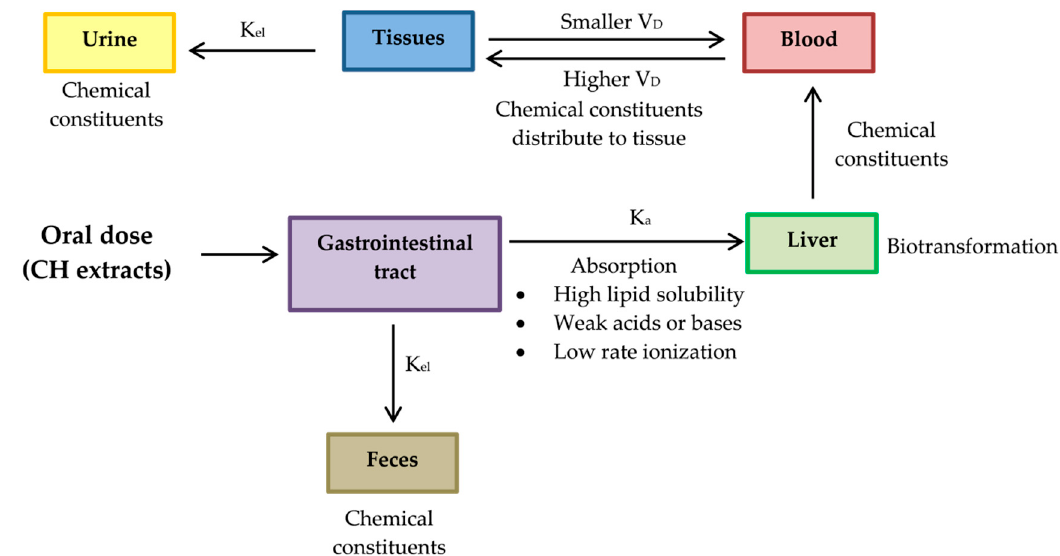
Figure 12. The proposed diagram of pharmacokinetics for evaluating of active phytochemicals of CH extracts. After chemical constituents are absorbed by gastrointestinal tract, they are delivered to liver, where they are biotransformed and delivered into blood. Chemical constituents are biodistributed to other peripheral organs by blood stream. Absorbed chemical constituents are excreted through the urine but certain chemical constituents that are not absorbed through the gastrointestinal tract will be eliminated through feces. Absorption rate constant (K a ); Constant elimination (K el ); Volume of distribution (V D ).